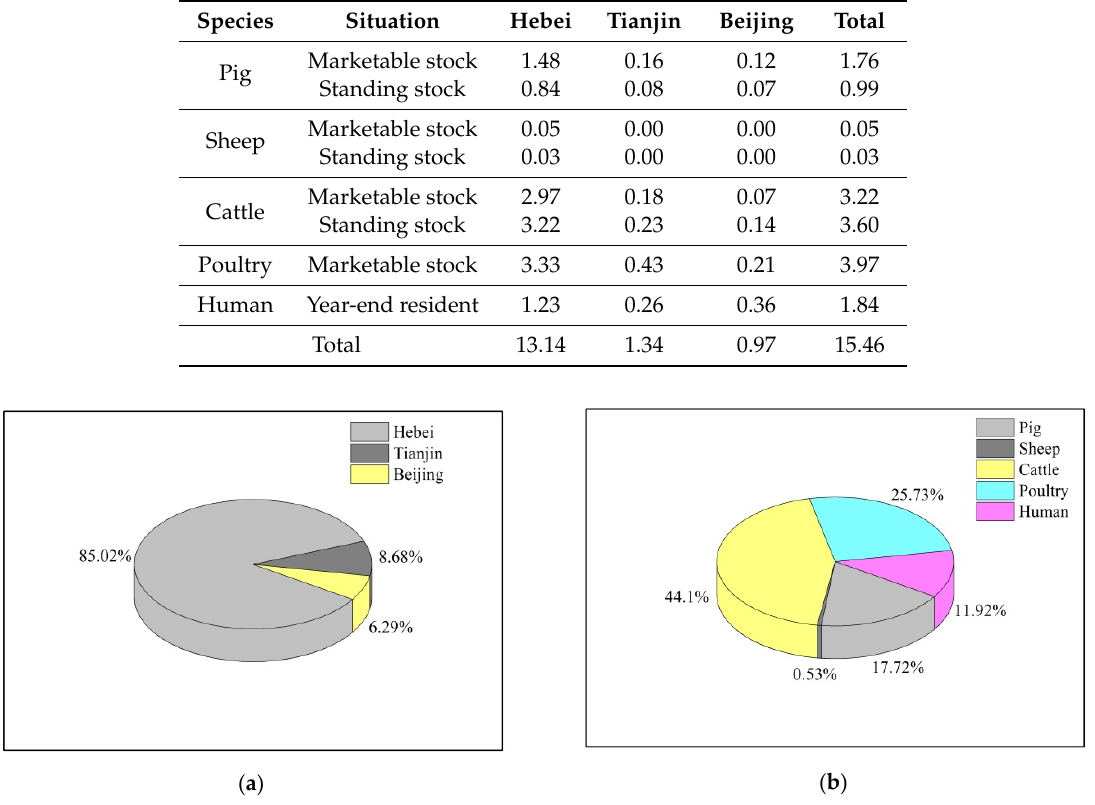
Figure 5. The COD value in the B-T-H region. ( a ) A pie chart of COD production in Hebei, Tianjin, and Beijing, respectively. ( b ) The COD value proportion of pigs, sheep, cattle, poultry, and humans,